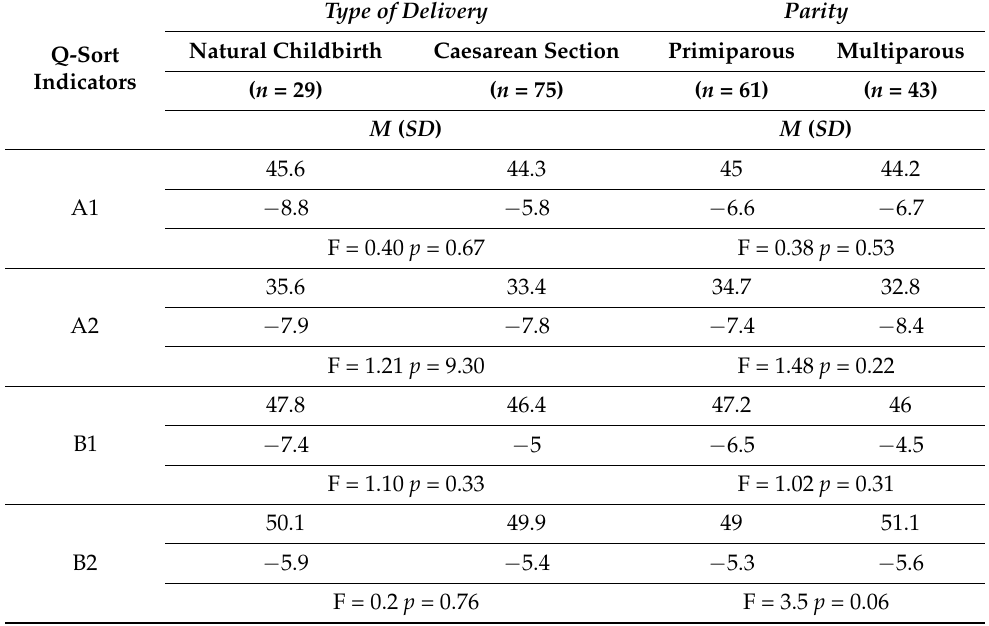
Table 9. Maternal competence (Q-sort scores) at the time of home (T2) in relation to type of delivery and parity (MANOVA) ( n =